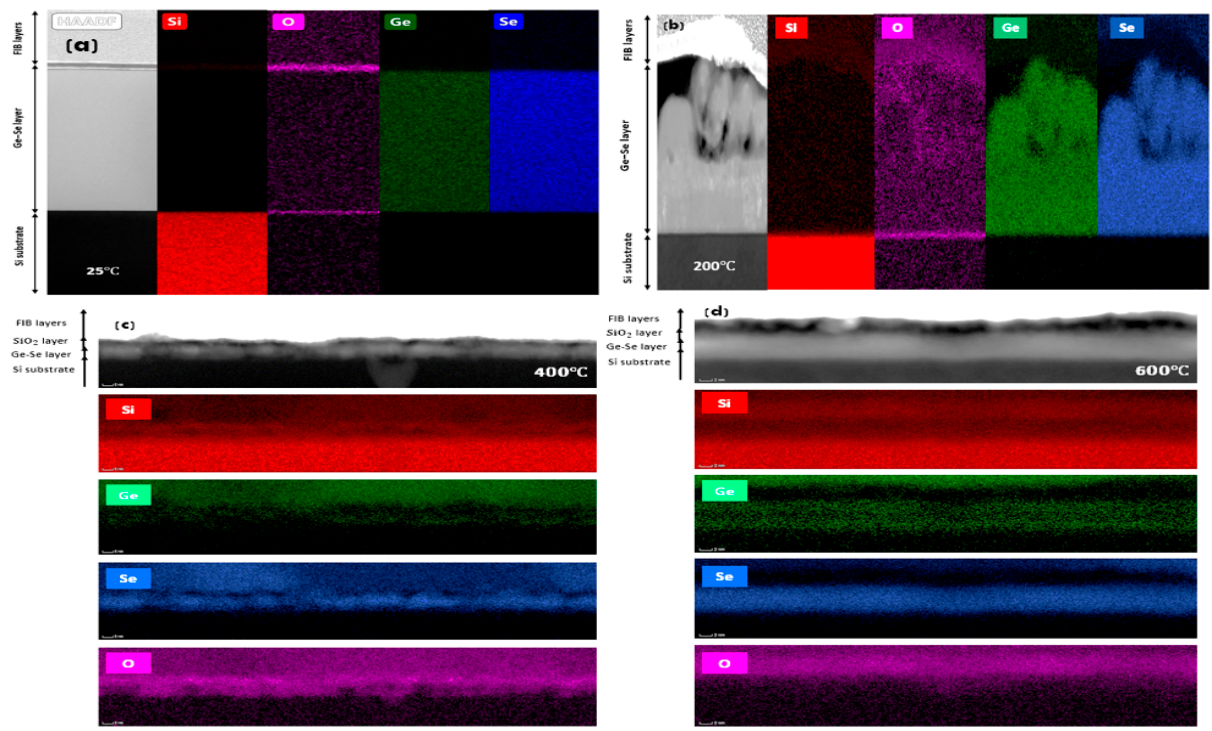
Figure 3. EDX-STEM elemental map images of Ge-Se thin films prepared on silicon at ( a ) 25 °C, ( b ) 200 °C, ( c ) 400 °C and ( d ) 600 °C.